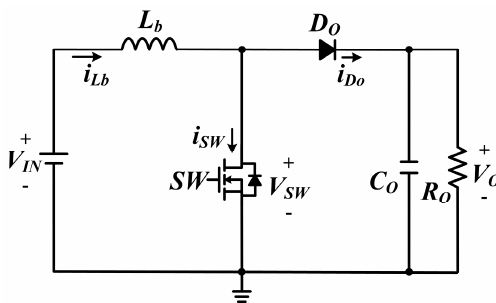
Figure 1. Schematic of conventional DC-DC boost converter.